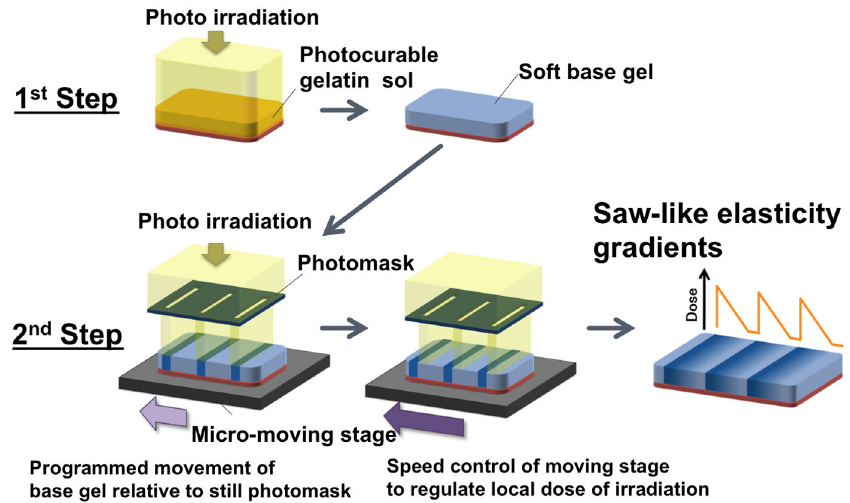
Figure 2. Schematic diagram showing how cell adhesive hydrogels with saw-like asymmetric elasticity patterns are fabricated. In the first step, a soft base gel is prepared by irradiation of a photocurable sol of styrenated gelatin with visible light. In the second step, the base gel is photo-irradiated through slits in a photomask for a defined period of time. The gel is continuously displaced in a perpendicular direction to the photomask at a defined speed using a computer-assisted X-Y movement stage. The duration of irradiation is set so that the StG sol surface is irradiated asymmetrically. doi: